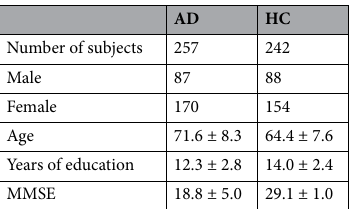
Table 1. Subject information of the Pitt dataset (AD vs. HC).